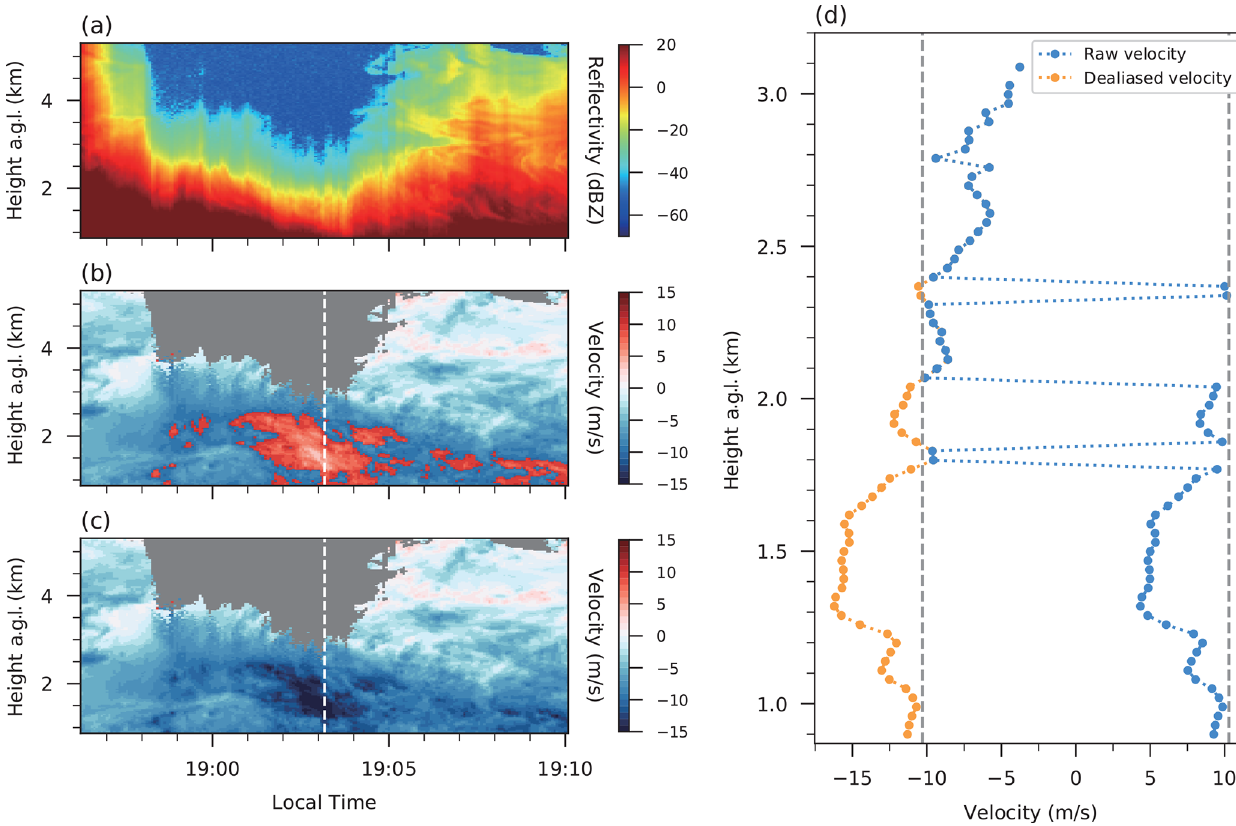
Figure 3. (a) Reflectivity, (b) radar-measured Doppler velocity, and (c) de-aliased velocity from 18:56 to 19:10LT on 30 August 2013. (d) Raw and de-aliased velocity profile of the dashed white line in the left panels; the dashed gray line is the maximum unambiguous velocity ( ± 10 . 38ms − 1 for SACOL KAZR). Positive velocity represents upwards